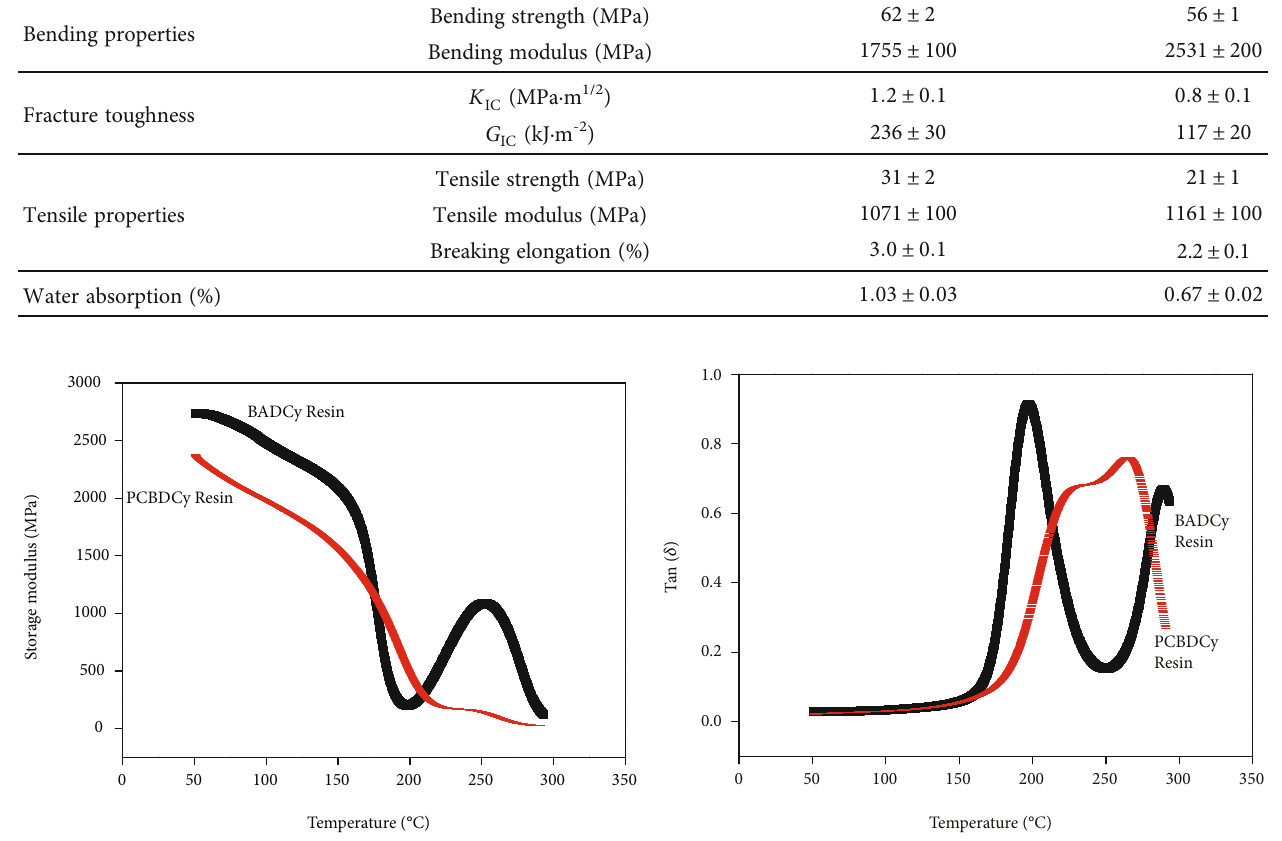
Figure 4: Storage modulus (a) and tan delta (b) of cured PCBDCy and